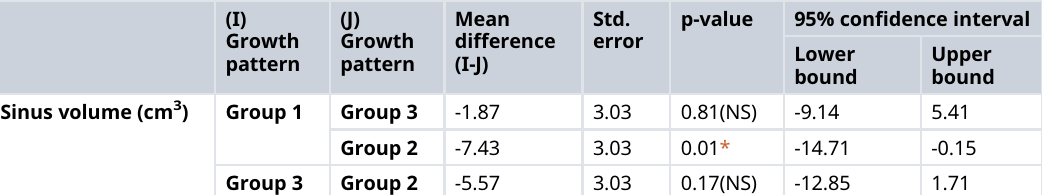
Table 3b. Pairwise comparison of sinus volume between the study